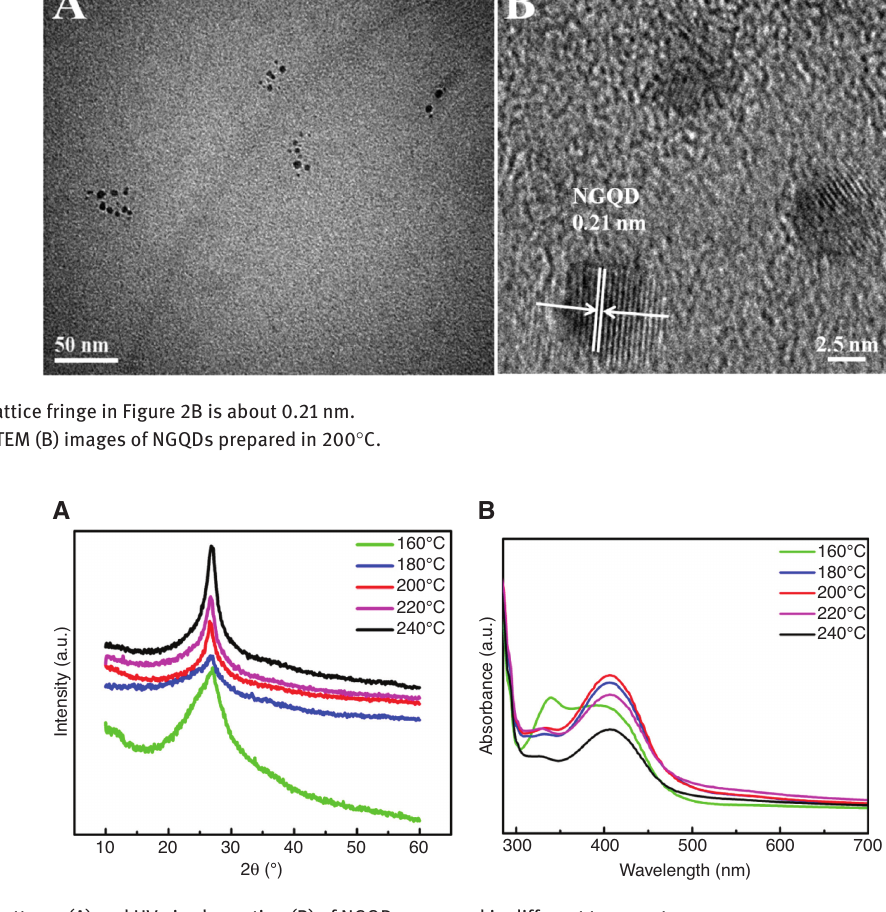
Figure 3: XRD patterns (A) and UV-vis absorption (B) of NGQDs prepared in different temperatures. The concentration of NGQDs dispersion is 0.5